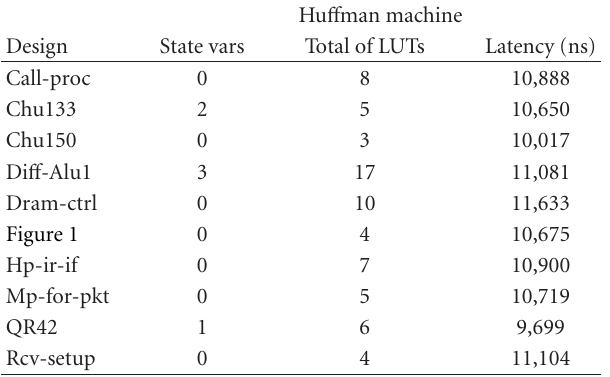
Table 2: Experimental Results to Hu ff man Machine The column State vars shows the variables of state.